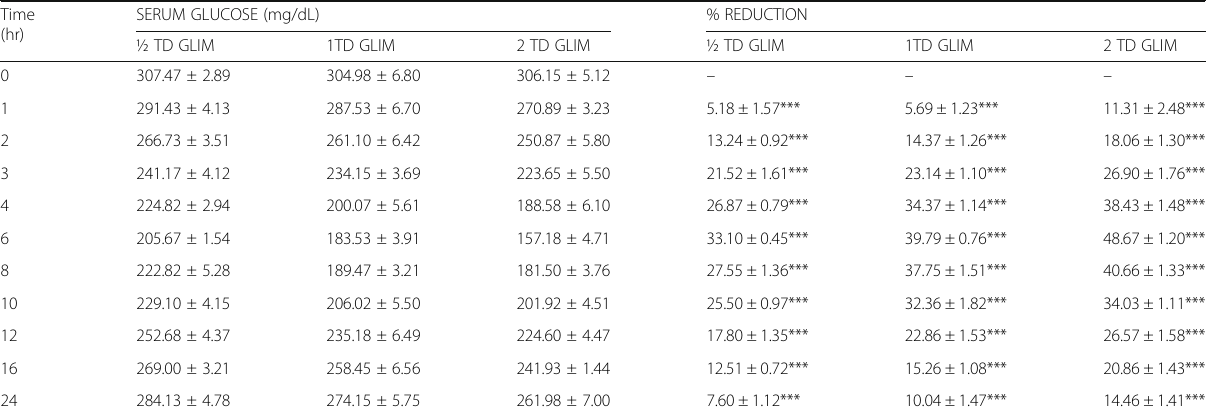
Table 2 Antidiabetic activity of Glimepiride (GLIM) in diabetic rats Time SERUM GLUCOSE (mg/dL) % (hr)